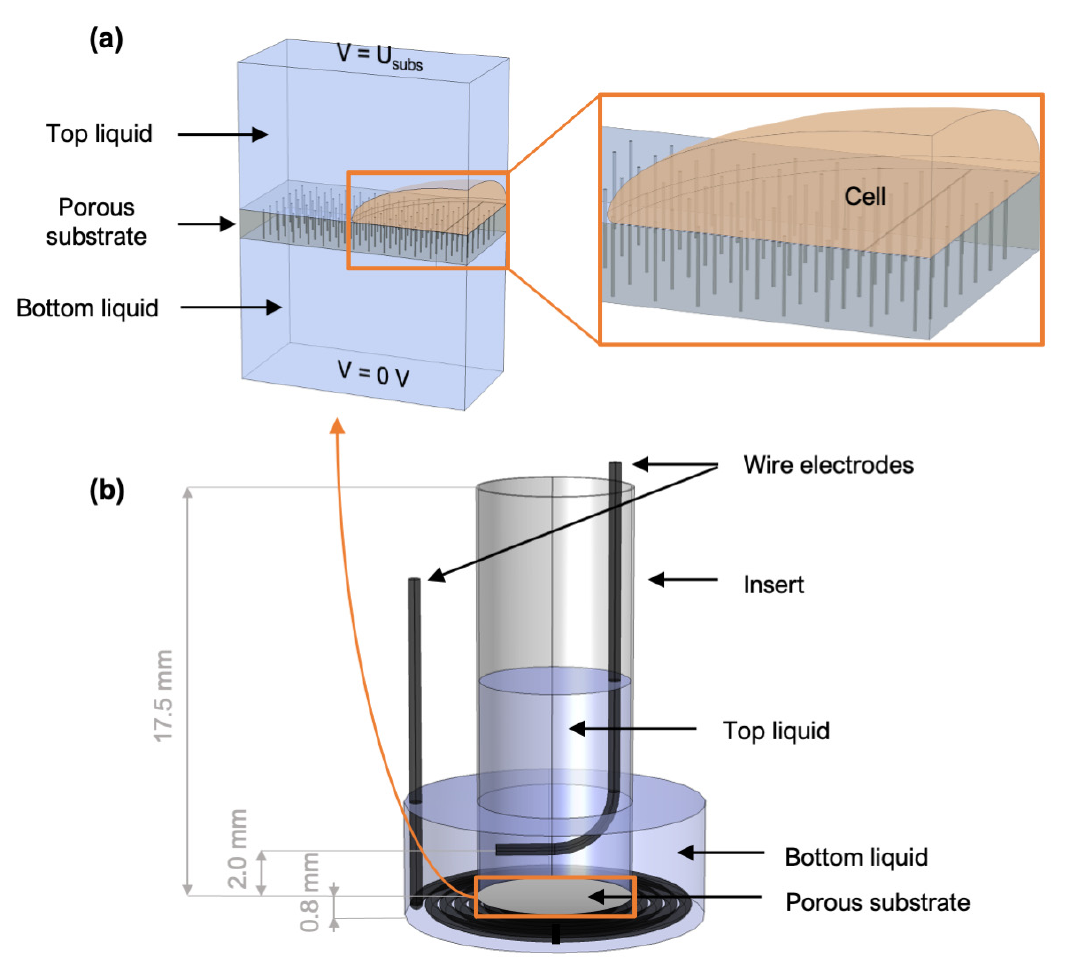
Figure 1. Geometry of the numerical models. ( a ) Model of a cell on top of a porous substrate. ( b ) Model of the full insert system.